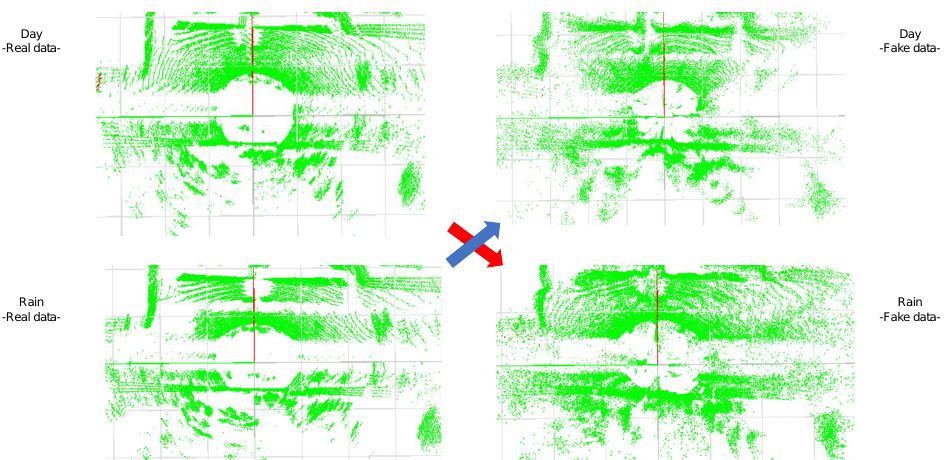
Figure 8. Example of translation between sunny and rainy conditions with the Spain data set. The results are reconstructed 3D points seen from above. The green points indicate reconstructed 3D points. In this figure, we show the translation from sunny to rainy condition. The images on the left are the real data for the source domains, while those on the right are the generated data for the target domains. The synthetic rain data were obtained by translation from the real day data, denoted by the red arrow. In addition, the synthetic day data were generated by translation from real rain data, as shown by the blue arrow. As there is no large difference between the day and rain data, the translation results showed no noticeable difference. We thus confirmed that the proposed method is applicable to real-world